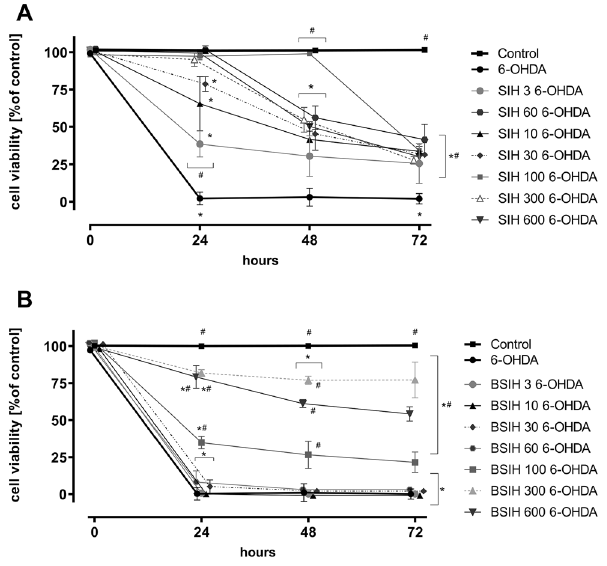
Figure 9. Comparison of protective effects of the Fe chelator SIH and prochelator BSIH against the toxicity of 6-hydroxydopamine (6-OHDA) in differentiated PC12 cells. Cellular toxicities were determined using SYTOX measurement and expressed as a percentage of viable cells and were related to untreated control. SIH ( A ) or BSIH ( B ) were added to the cells with freshly-prepared 6-OHDA (protocol PI ). Data are presented as means ± SD ; n ≥ 4; Statistical significance (ANOVA, p ≤ 0.05): * vs. control group, # vs. 6-OHDA. Statistical significance is also displayed in tables in Supplementary Figure